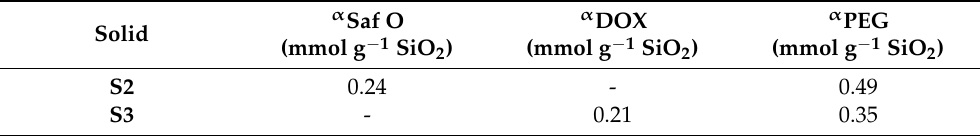
Table 1. BET speci fi c surface values, pore volumes, and pore sizes calculated. Table 2. Content ( α ) of anchored molecules and cargo in millimoles per gram of SiO 2 for solids S2 and Solid